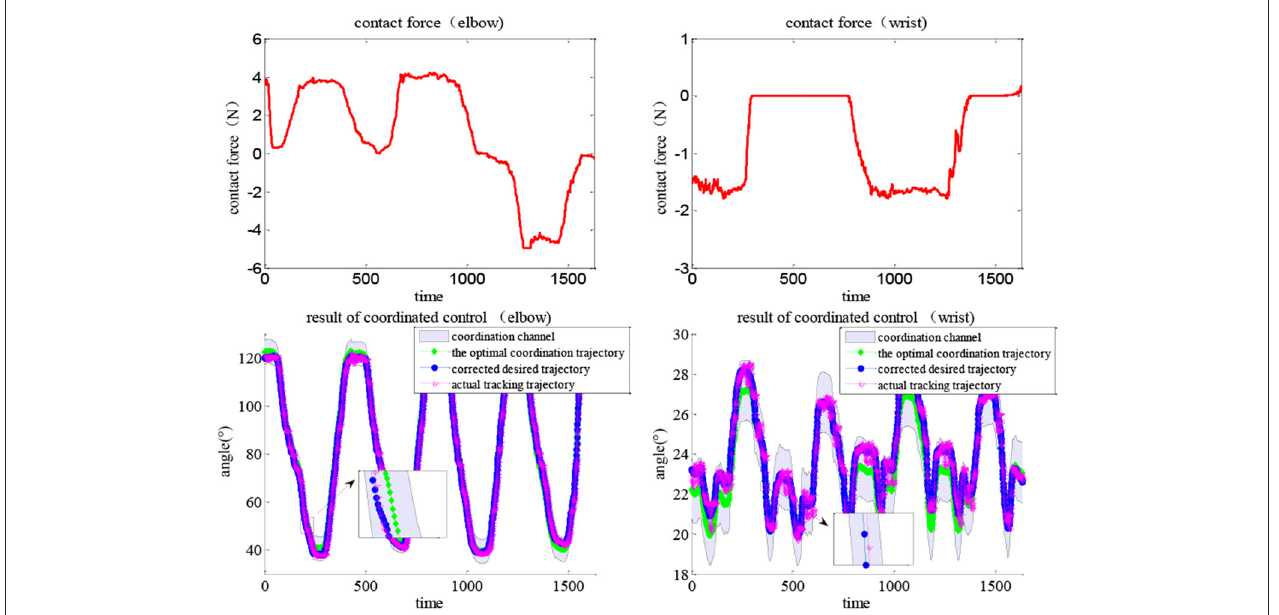
FIGURE 17 | Control results without impedance adjustment under Task 1, the actual trajectory might be out of the coordination channel.